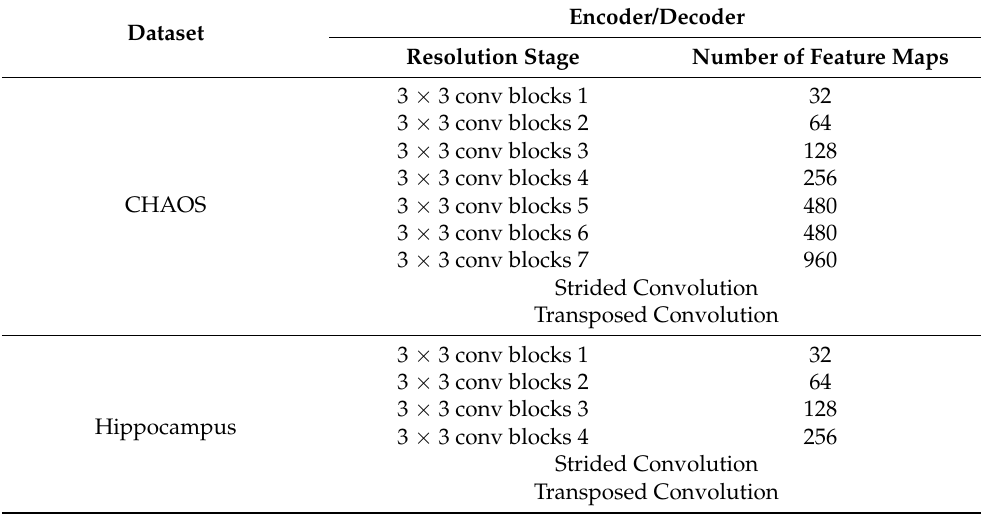
Table 1. The configurations of nnU-Net encoder and decoder layer in our experiments on CHAOS and hippocampus datasets.